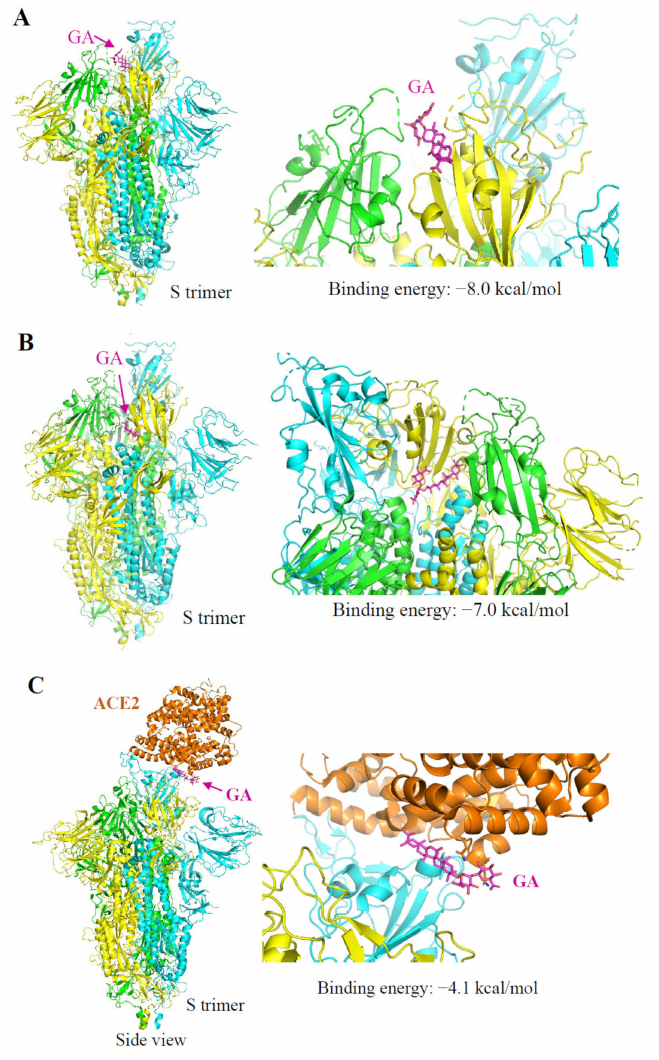
Figure 5. Autodocking analysis of GA interaction with SARS-CoV-2 S and ACE2 protein. Three protomers of SARS-Cov-2 S protein (PDB id: 6vsb) are shown in cyan, green, and yellow, respectively. ACE2 protein (PDB id: 6m18) is in orange. The structure of proteins is presented in ribbons. The structure of GA (ZINC id:960251743495) is shown in magenta as sticks. Arrows indicate the predicted binding site of GA. ( A ) Predicted binding of GA on the S protein at the S–ACE2 interface with a calculated binding energy of –8.0 kcal/mol. ( B ) Predicted binding of GA on a binding pocket located at the inner side of the RBD with a binding energy of − 7.0 kcal/mol. ( C ) Predicted binding of GA on the ACE2 protein at the ACE2–S interface with a binding energy of − 4.1